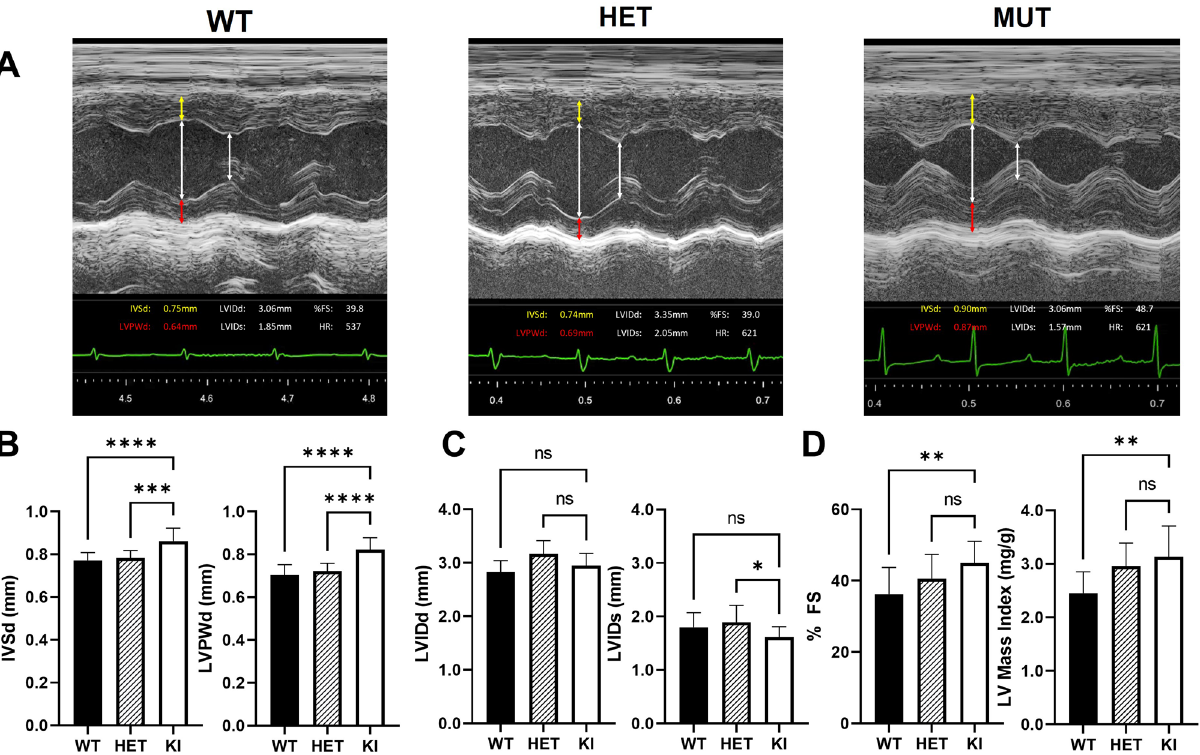
Figure 6. Three-month-old Gaa em1935C > A KI mice display anatomical features of left ventricular cardiac hypertrophy. ( A ) Representative M-mode echocardiographic images showing cardiac dimensions: IVSd: yellow arrows; LVPWd: red arrows, and LVIDd / LVIDs: white arrows. ( B ) KI IVSd and LVPWd are significantly increased versus WT and HET animals, indicative of concentric hypertrophic cardiomyopathy. ( C ) LVIDd and LVIDs do not significantly differ between WT, HET, and KI animals. ( D ) KI fractional shortening is significantly increased versus WT indicative of hyperdynamic contractility; KI LVMI is significantly increased versus WT indicative again of hypertrophic cardiomyopathy. All measurements from WT (n = 12; black bars), HET (n = 10; striped bars), and KI ( Gaa .em1935C > A ; n = 10; white bars) mice were obtained from 3-month-old mice. Data are shown as mean ± SD. Heart rate (HR) was maintained greater than 500 bpm throughout measurements. All comparisons were analyzed using one-way ANOVA with the Tukey post-hoc test. * p < 0.05, ** p < 0.01, *** p < 0.001, **** p < 0.0001. ns: not